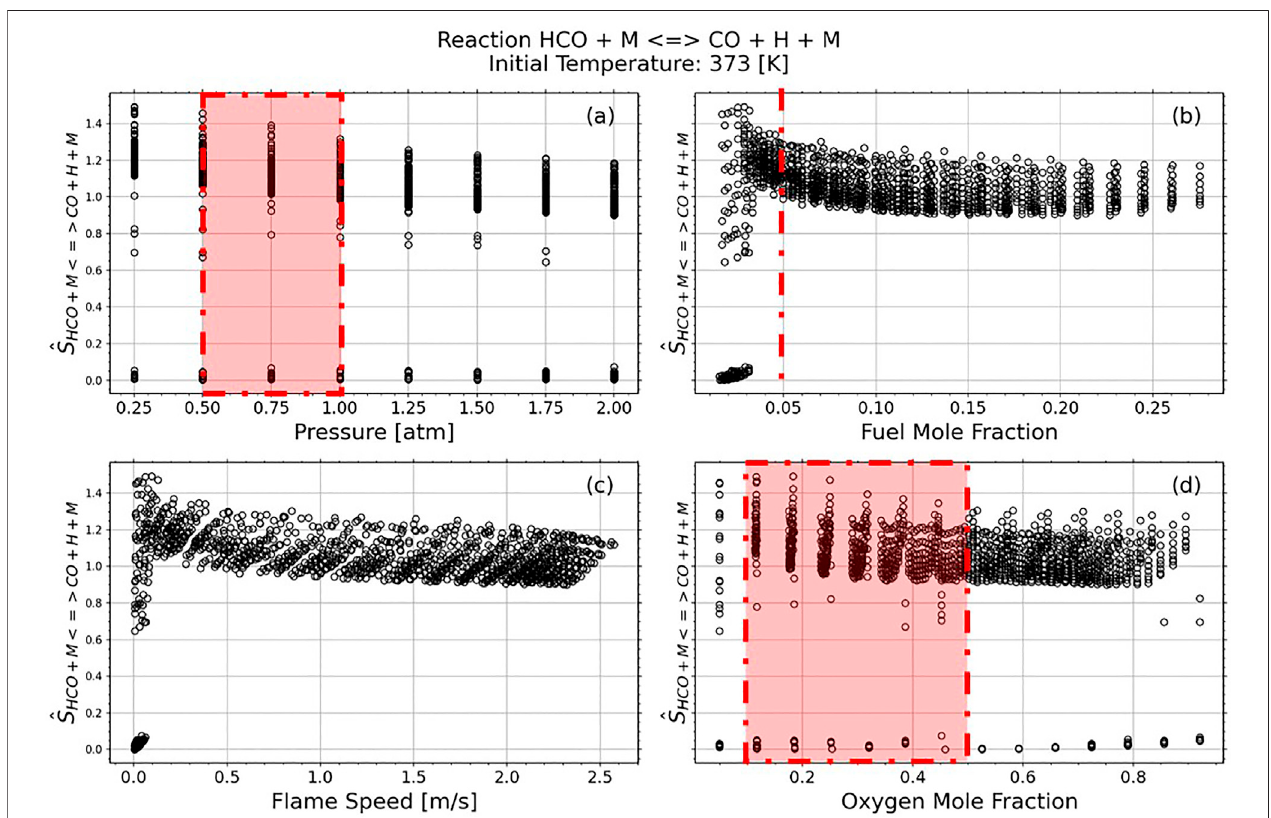
FIGURE 6 | Reaction 30 HCO + M ↔ CO + H + M Normalized Sensitivity Strength against the top seven reactions per case. The red dashed lines indicate experimental conditions from Santner et al. (2015).